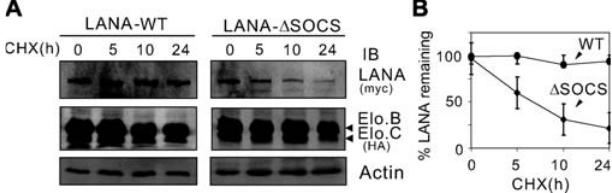
Figure 4. Binding to the Elongin BC Complex Stabilizes LANA (A) The stabilities of WT LANA and its SOCS motif mutant. Five million Saos-2 cells were transfected with 5 l g of LANA-WT (left panel) or LANA- D SOCS (right panel) expression vector in the presence of 5 l g of Elongin B and 5 l g of Elongin C expression vectors, as indicated. Twenty-four hours after transfection, cells were treated with 100 l g/ml cyclo- hexamide (CHX) for different times (0, 5, 10, and 24 h). Aliquots (40 l g) of each whole-cell extract underwent IB with the indicated antibodies. (B) The relative levels of WT LANA and its SOCS mutant coexpression with Elongin BC complex. Protein density was quantitated by densitometry of immunoblots using Odyssey Image v1.2 from three separate experiments. DOI: 10.1371/journal.ppat.0020116.g004